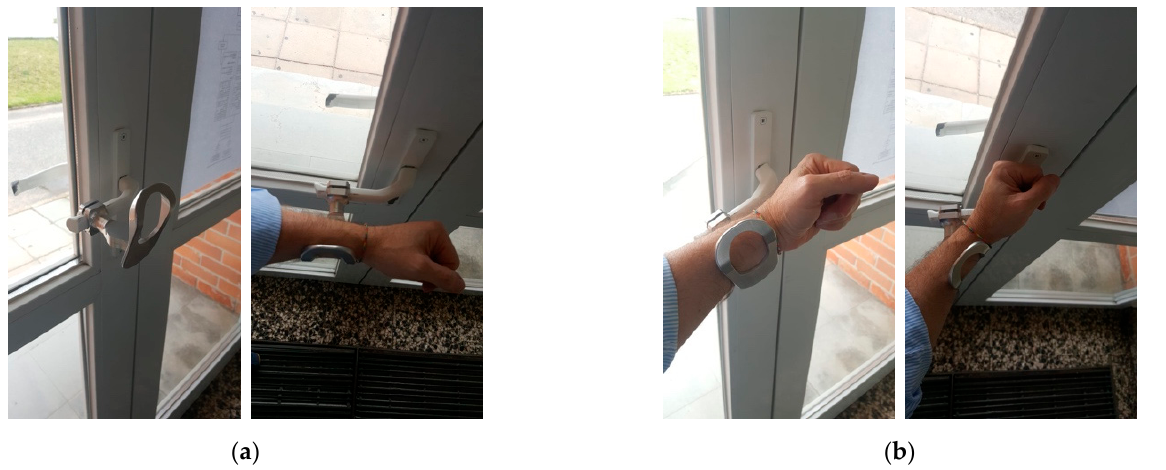
Figure 16. Dynamic system: ( a ) visualization of the system clamped in the handle and the hand position for opening; ( b ) sequence of opening performed by a volunteer.